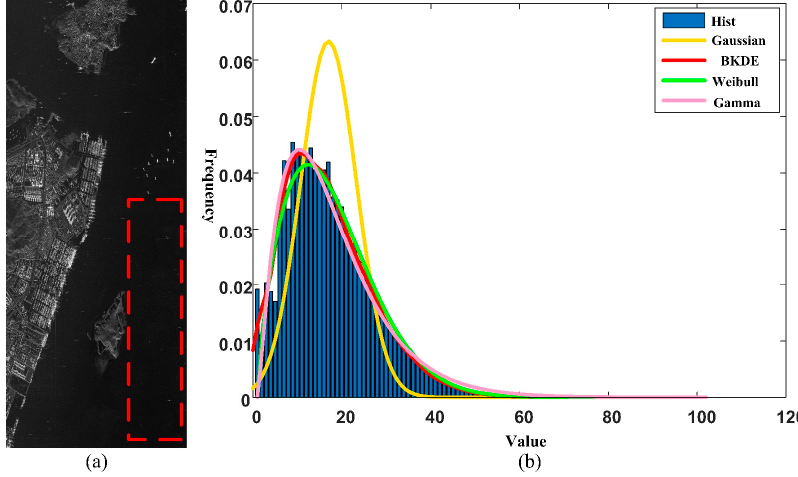
Figure 6. Comparison of clutter fitting result. ( a ) Clutter region. ( b ) Histogram fitting results.